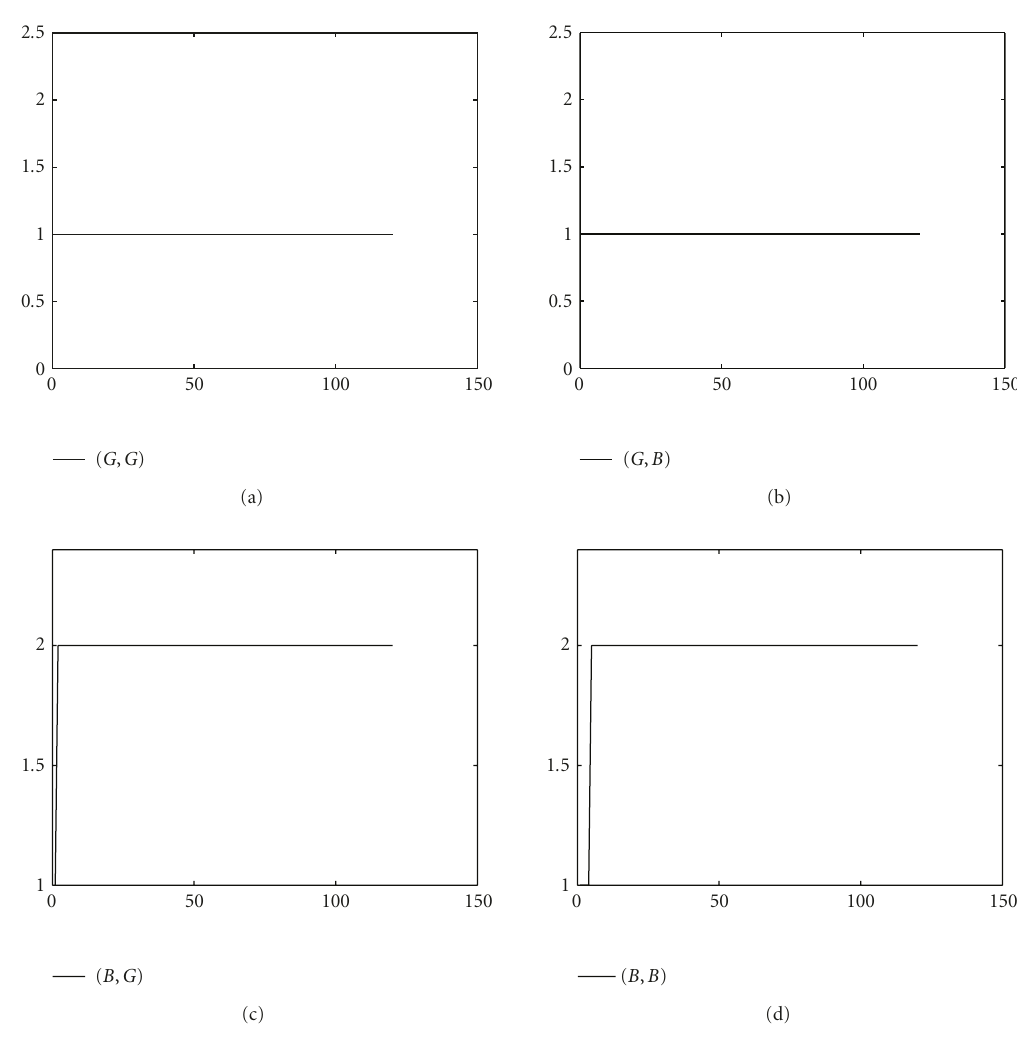
Figure 3: Link scheduling without bu ff er load control. Horizontal axis: bu ff er level; vertical axis: scheduler